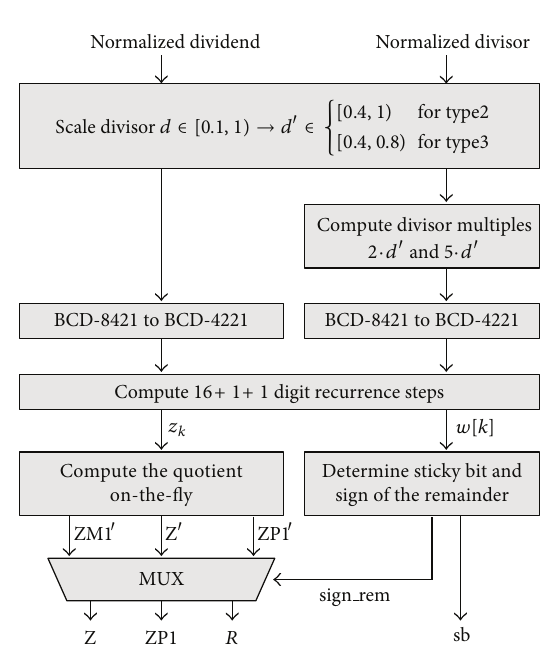
Figure 9: Block diagram of the normalized type2, type3.a, type3.b, and type4